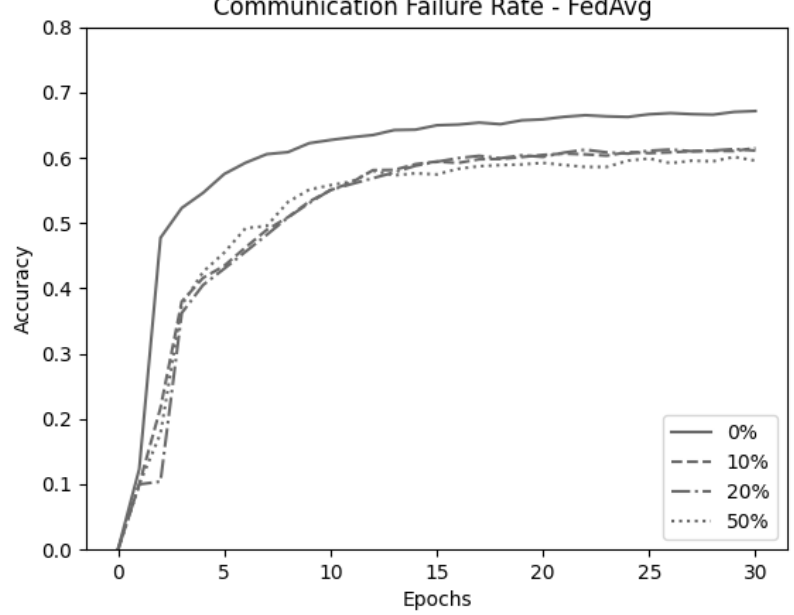
Figure 7. Comparison of FedAvg ( C = 1.0) test accuracy in unstable network conditions.